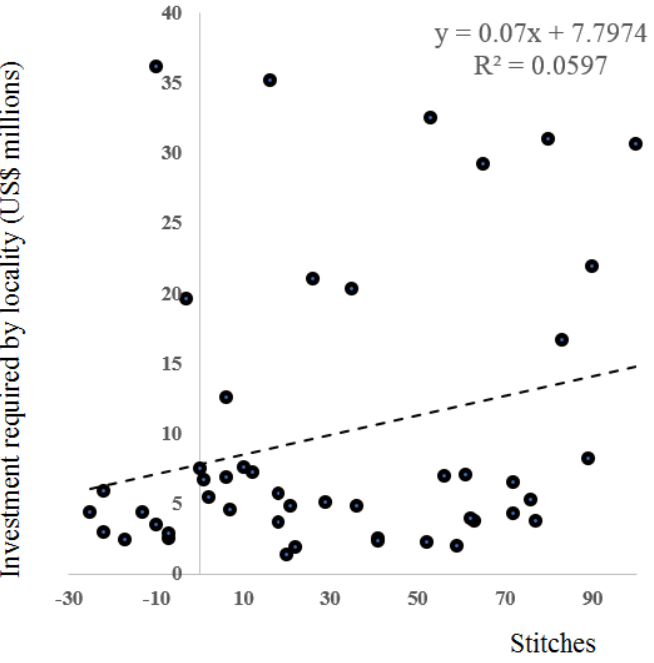
Figure 6. Plot of investment against value. Source: research data. The data relating to investment as a function of attractiveness presented in Graph 1 indicate that attractiveness is insufficient to explain the variation in investments projected for airports, given the observed dispersion. The trend line (dashed line) reveals a slight slope, indicating a growth of around 0.07 million USD in the level of investment through the growth of one unit of attractiveness. were below 10 million USD. In a few airports, investment levels were above 30 million USD, with emphasis on two airports, Fernando de Noronha and Aracati (Table 12), with low levels of attractiveness but high amounts of investment. Forty-seven locations included under the RADP were evaluated, since six airport sites were granted to the private sector in 2019 from the list of 53 locations included in the program. Although the general ranking of the attractiveness of cities had a certain predomi- nance of municipalities in the south and southeast regions, in the first half of the ranking, municipalities from all country regions were observed. The data show that even the most populated Brazilian regions still lack regional air transport infrastructure investment. The overall ranking highlights several locations that already have some type of reg- ular flight infrastructure. However, a locality already having regular flights does not mean that the infrastructure is satisfactory. In many cases, trips are made on small or medium- sized aircraft due to airport infrastructure restrictions. Therefore, airport infrastructure improvement is necessary for the expansion of services, either for the receipt of aircraft appropriate to the existing demand or for improving safety and comfort conditions. Analysing the data presented in Table 12, it can be verified that the investments needed to meet the 10 best-ranked locations add up to 157.22 million USD. To build or improve the airport infrastructure of the 20 best locations, 225.26 million USD would be required. Lastly, with about 270 million USD, it would be possible to serve half of the cities selected under the RADP. Several studies cited in the literature review presented a methodology for, in some way, classifying Brazilian municipalities or regions concerning the need for investments in regional aviation.